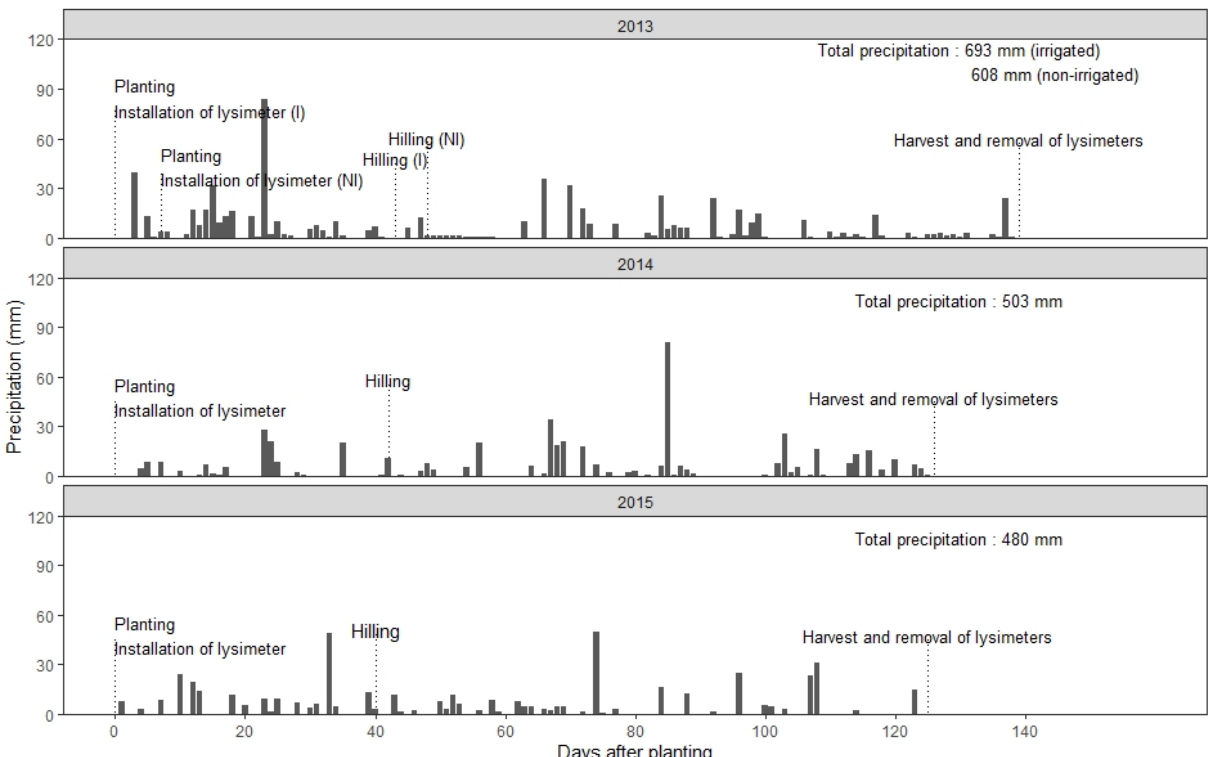
Figure 2. Daily precipitation and main field operations in 2013, 2014, and 2015 at irrigated (I) and non-irrigated (NI) sites.